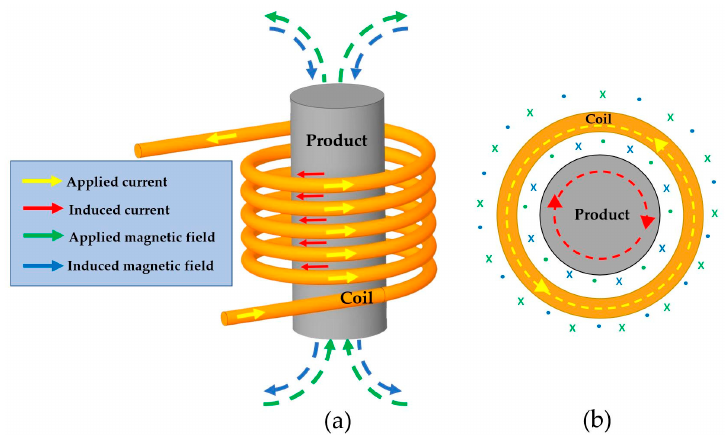
Figure 2. The equipment for heat induction, including currents and magnetic fields viewed from ( a ) the side and ( b ) the top. ( a ) the side and ( b ) the